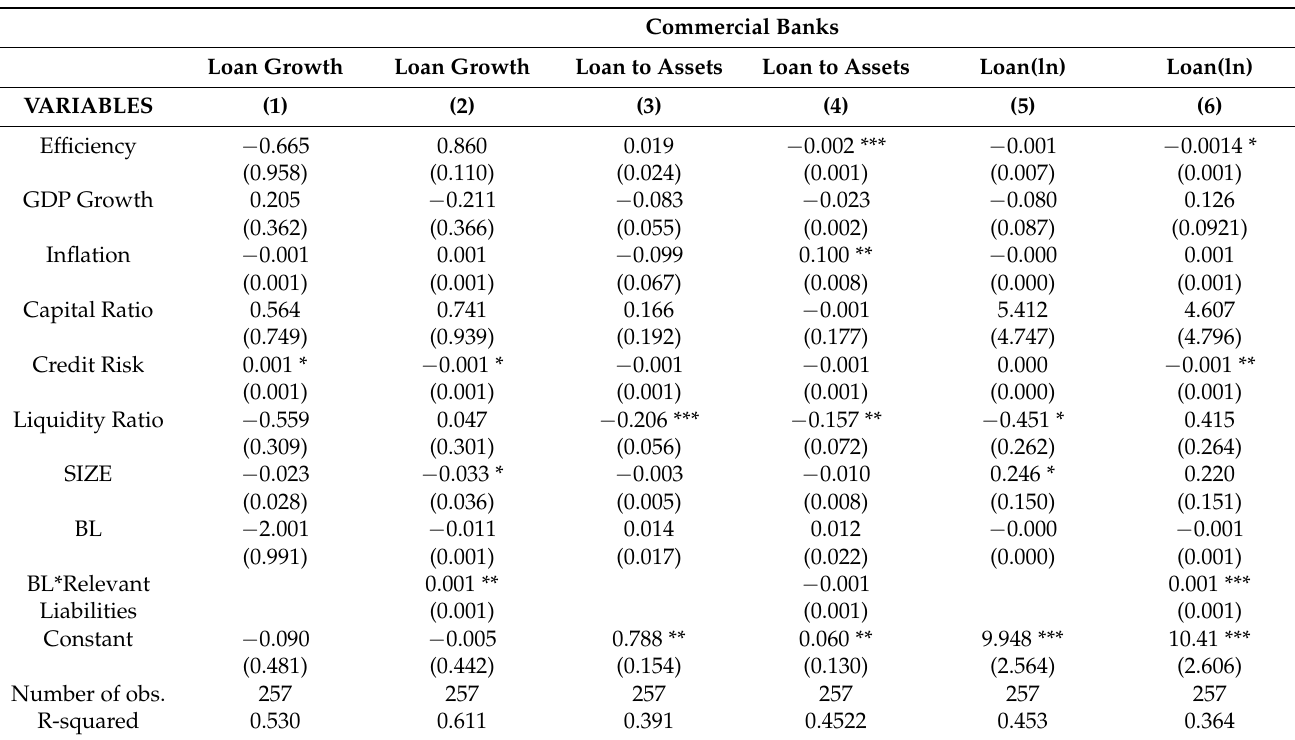
Table 7. Data presenting estimates based on GLS regressions with a random effect on all German commercial banks. Symbols *, **, and *** represent statistical significance at the levels of 10%, 5%, and 1%,